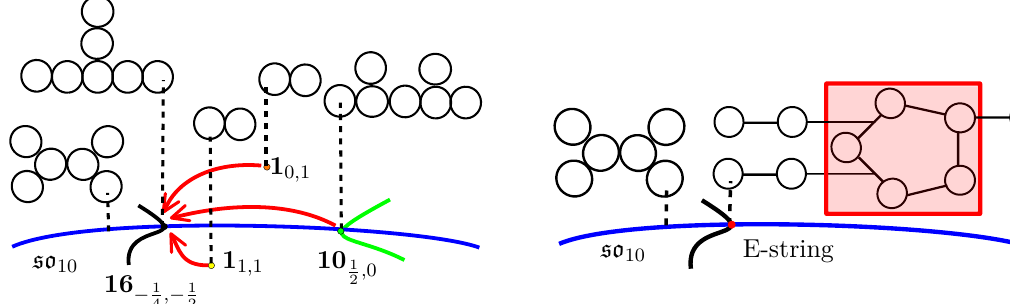
Figure 6 . The fiber structure of the (SO(10) × U(1) 2 ) / Z 4 model. On the left a complex structure deformation tunes four matter representations onto the same point while keeping codimension one fibers inert. Over this point the resulting fiber becomes non-flat which is shown via the red surface on the